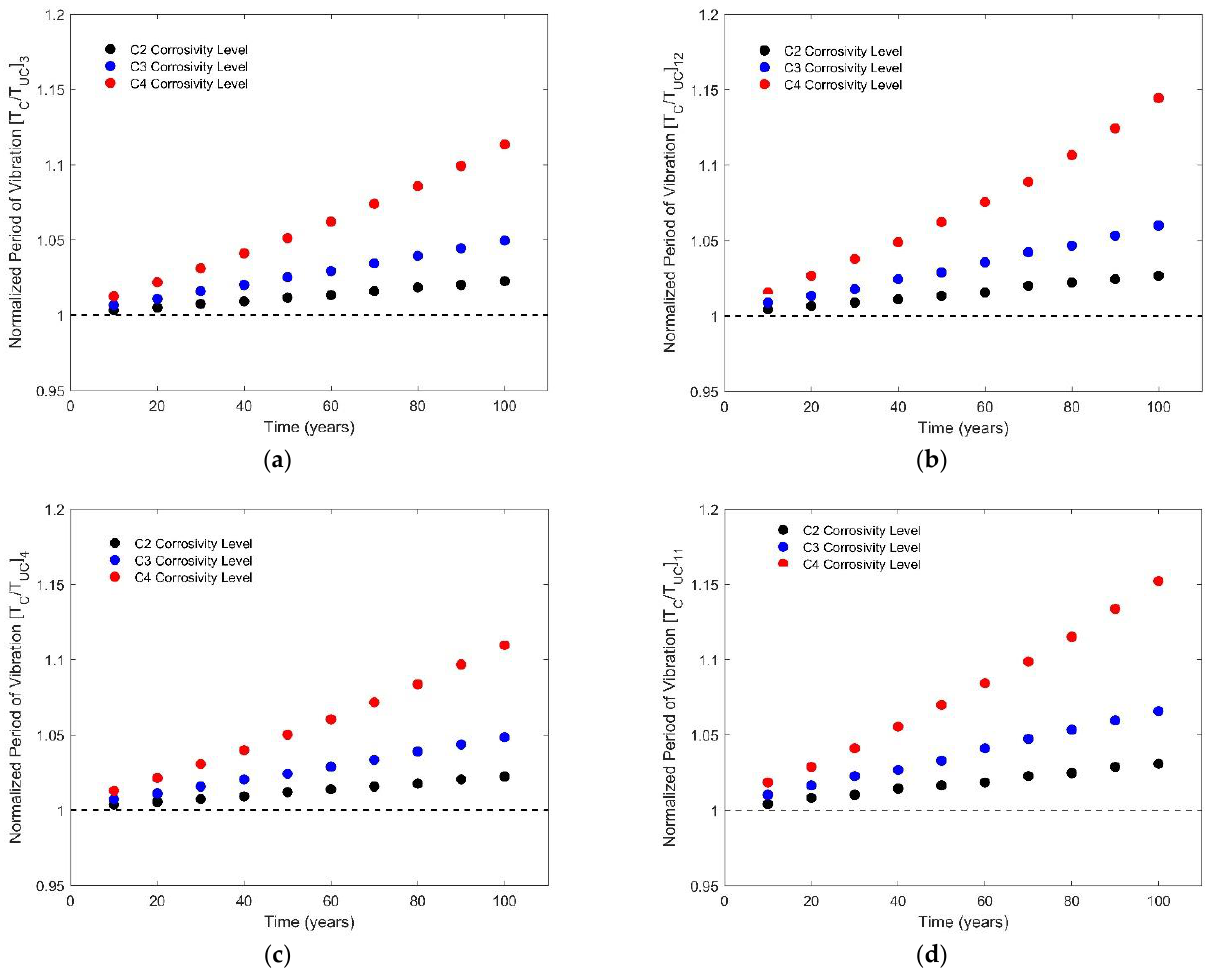
Figure 8. Normalized period of vibration with respect to exposure time (entire section mass loss) for: ( a ) mode no. 3 in Y direction; ( b ) mode no. 12 in Y direction; ( c ) mode no. 4 in X direction; ( d ) mode no. 11 in X direction. (T C and T UC refer to corroded and uncorroded cases, respectively).